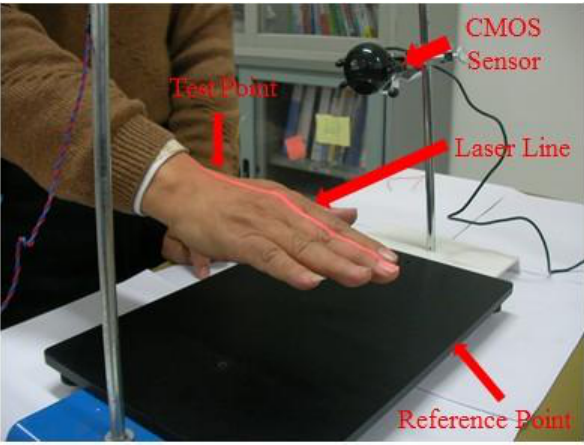
Figure 8. Hand detection method for postural action